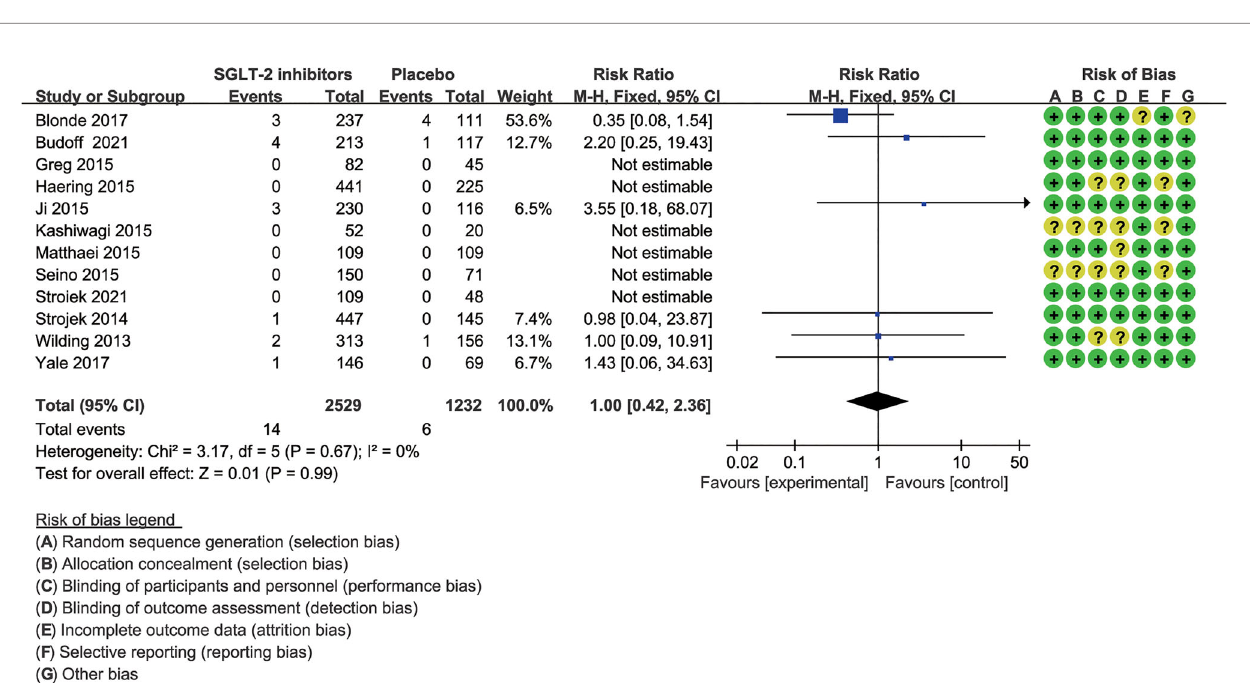
FIGURE 5 | Risk of severe hypoglycemia. Forest plot showing risk of severe hypoglycemia in patients treated with SGLT-2 inhibitors plus sulfonylureas compared with placebo plus sulfonylureas.